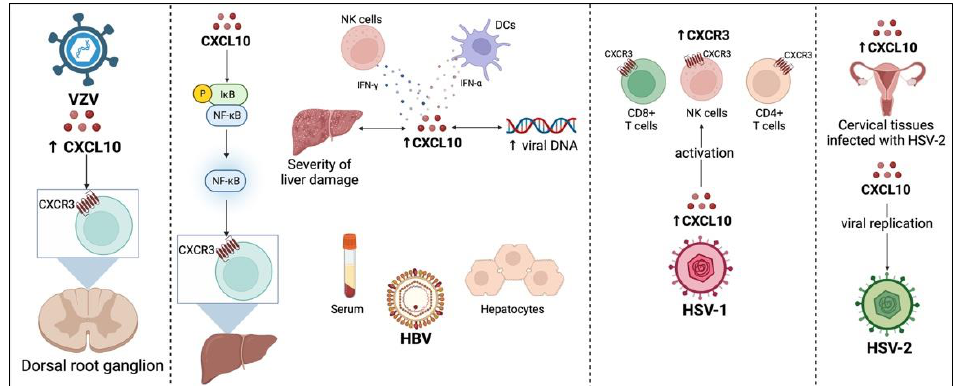
Figure 2. Role of CXCL10 during DNA viral infections. HBV: hepatitis B virus, HSV: herpes simplex virus, VZV: varicella-zoster virus.